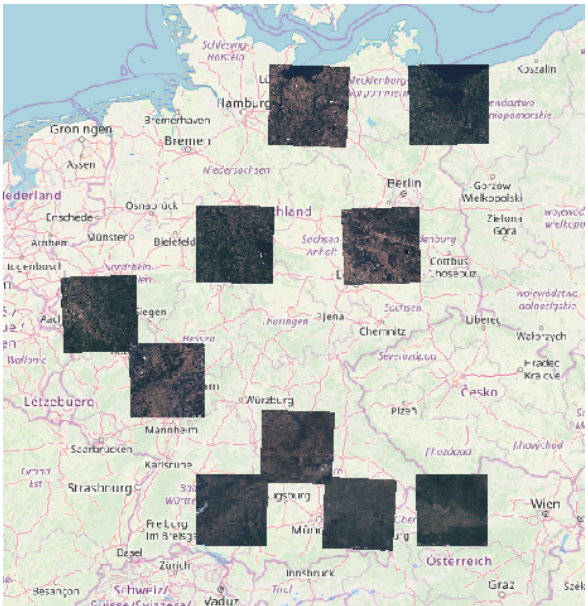
Figure 5. Footprints of the Sentinel-2 images used in our experiments. The distribution considers the varying topography of Germany from North to South, as well as Figure 4. Qualitative comparison of results. The bilinear temporal variations of the vegetation throughout the year. interpolation (a) is used as input for our network that Cloud coverage in all used images is less than predicts a residual image (b). By adding (b) to (a), the HR output (c) is generated. In comparison to the interpolation result, our method produces much clearer images that are more similar to the ground-truth (d).